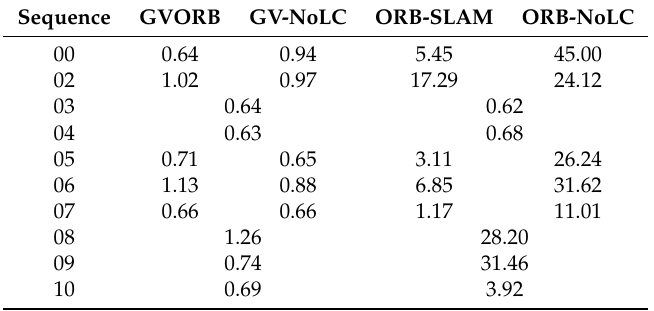
Table 3. Median root-mean-square error (RMSE) values of position estimation (m).